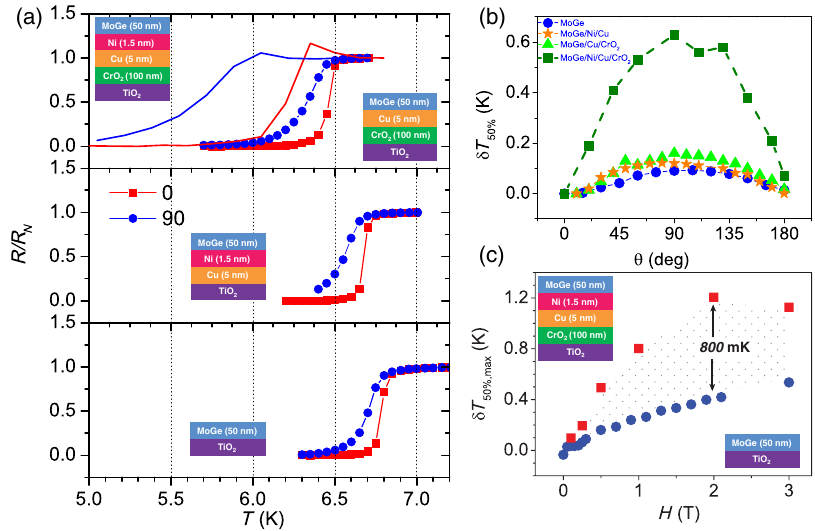
FIG. 3. Non-triplet-generating layer combinations. (a) Transition curves for MoGe ð 50 nm Þ = Cu ð 5 nm Þ = CrO 2 ð 100 nm Þ (top), MoGe ð 50 nm Þ = Ni ð 1 . 5 nm Þ = Cu ð 5 nm Þ (middle), and MoGe(50 nm) (bottom) for θ ¼ 0 ° and θ ¼ 90 ° at 0.25 T. The top panel also shows the results of the spin valve device TSV50a as drawn lines. (b) δ T 50% as a function of θ for these layered devices and for TSV50a ¼ T ; ð 0 ° Þ − T ; ð 90 ° Þ as a function of applied field for MoGe(50) and at 0.25 T. (c) Variation of T 50% ; 50% 50% max